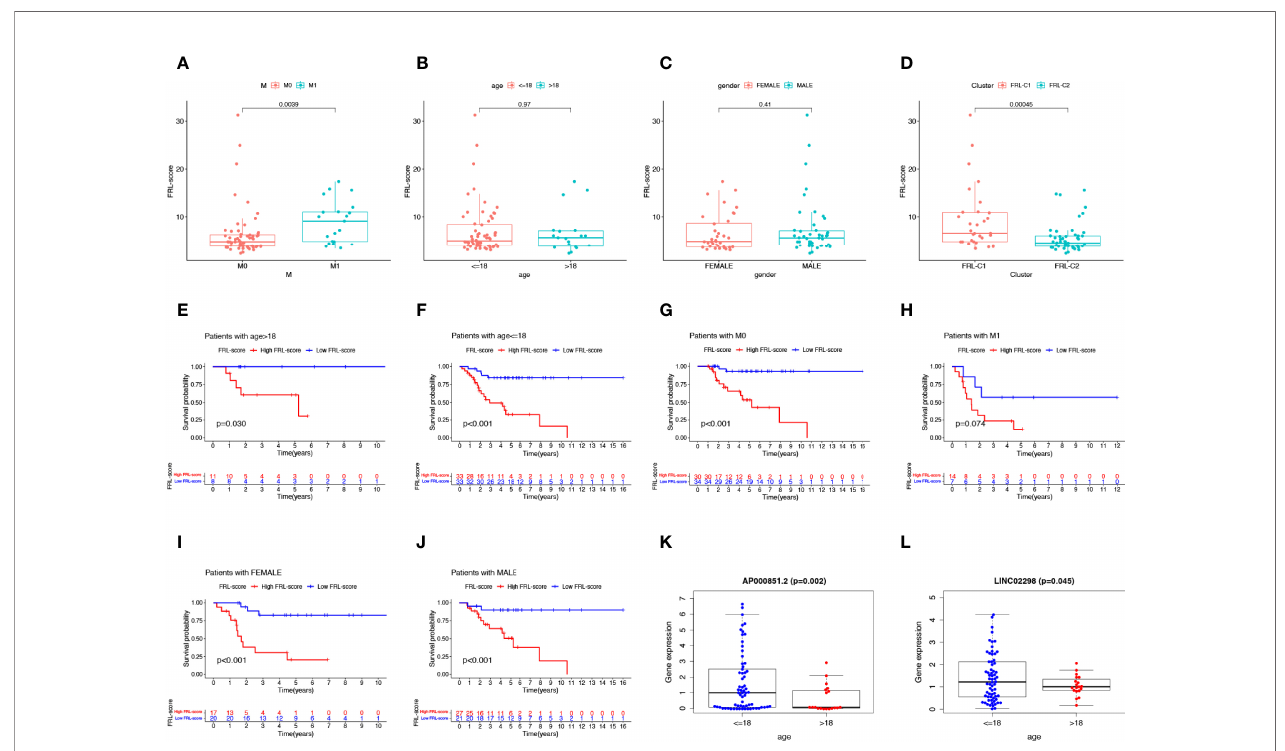
FIGURE 6 | Clinical correlation analysis and strati fi cation analysis of the FRL-score. (A – D) The correlation between the FRL-score and metastatic stage (A) , age (B) , gender (C) , and molecular subgroups (D) . (E – J) Strati fi cation survival analysis of patients in different clinical subgroups, including women (E) , men (F) , M0 stage